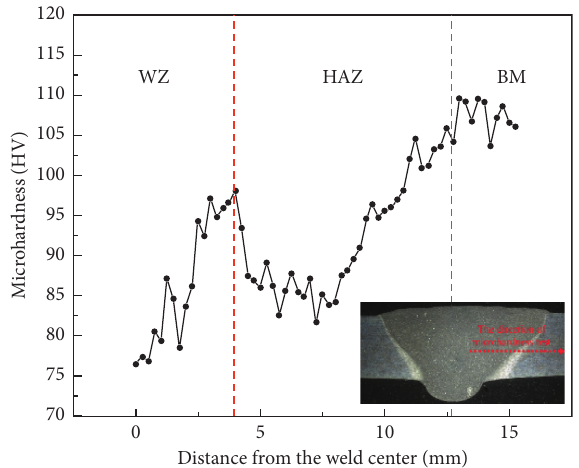
Figure 5: Microhardness of laser-MIG hybrid welded joint of 6061aluminum